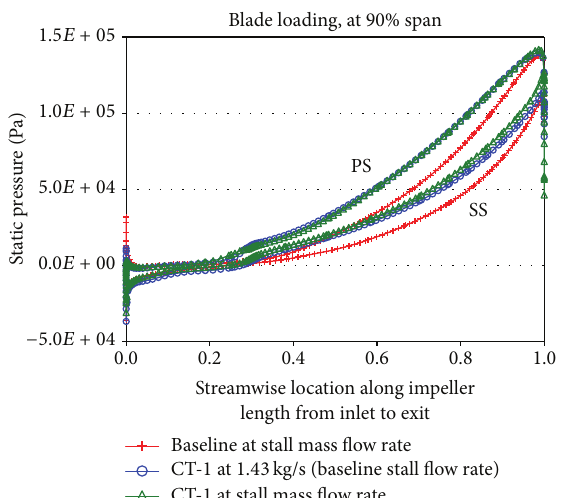
Figure 18: Comparison of blade loading of baseline impeller and impeller with CT-1 casing treatment at respective stall mass flow rates.